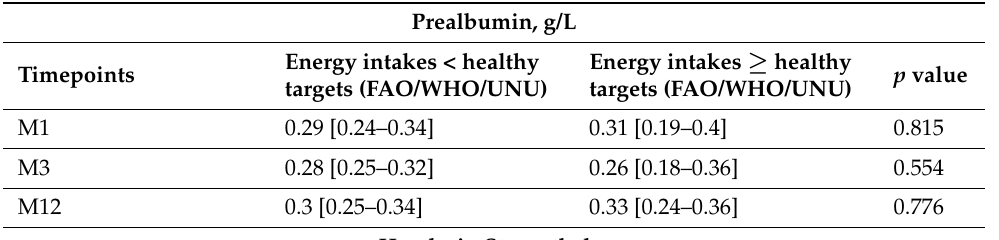
Table 4. Differences in outcomes (prealbumin and handgrip strength) according to nutritional intake adequacy based on healthy